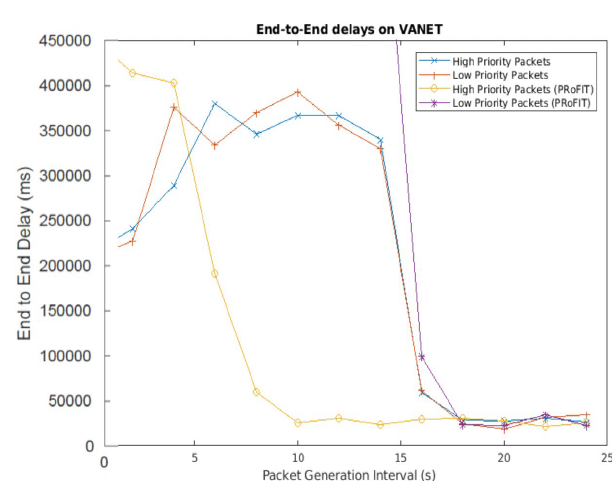
Figure 14 . End-to-End Delays on VANET with PRoFIT